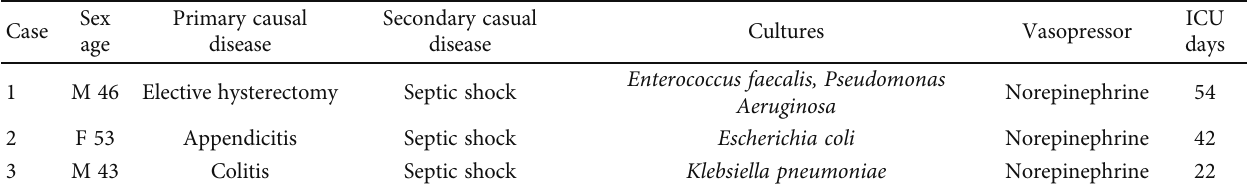
Table 1: Summary of the demographic and causal factors of the three cases.